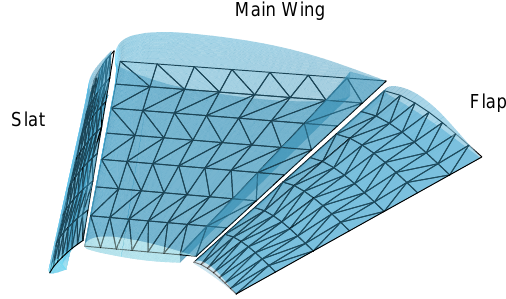
Figure 10. NASA Trap Wing LaRC Configuration 1 modelled using higher-order